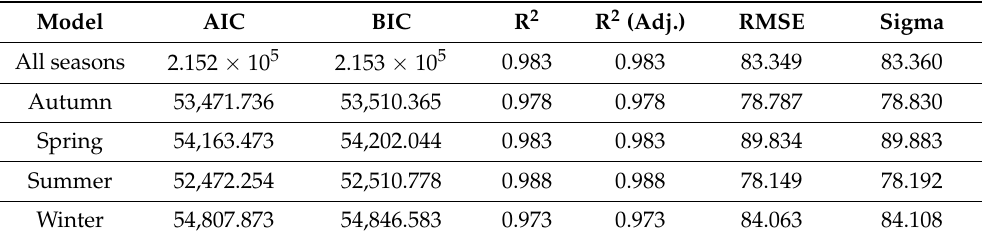
Table 4. Results of the performance analysis for selected regression models.